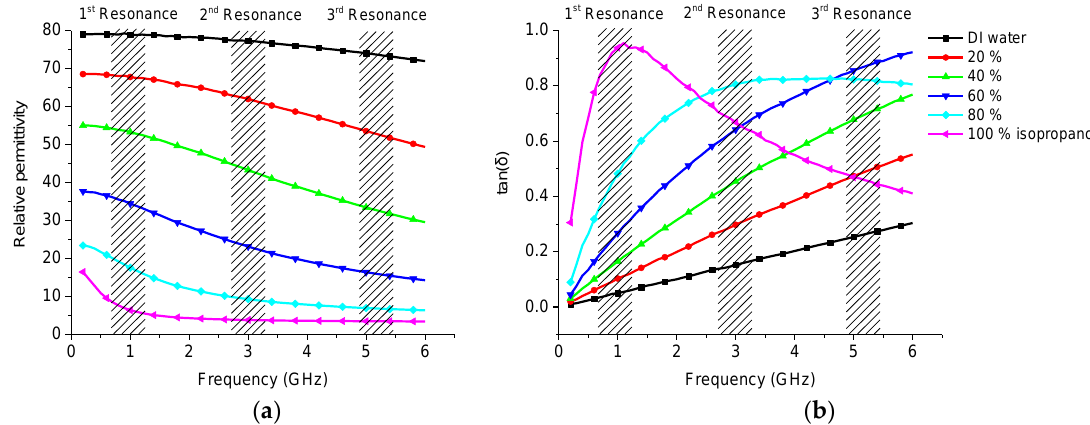
Figure 10. Dielectric properties of the isopropanol-water mixtures measured with DAK: ( a ) permittivity; ( b ) loss tangent.